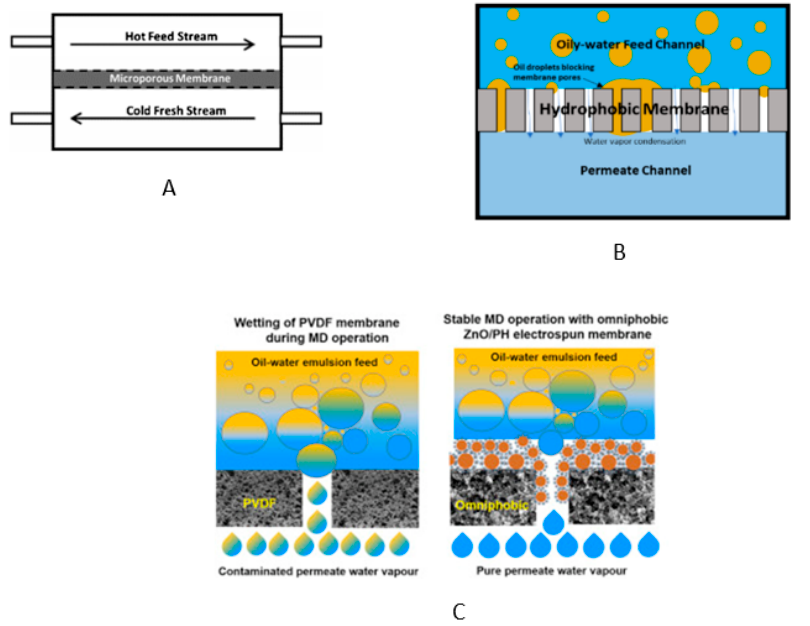
Figure 11. ( A ) Schematic diagram of counterflow direct contact membrane distillation system, ( B ) blockage of membrane pore due to hydrophobic–hydrophobic interaction, ( C ) wetting of PVDF membrane and omniphobic membrane with unwetting properties. Reprinted with permission from ref. [208]. Copyright 2019 Elsevier Ltd.